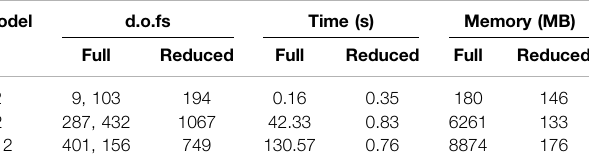
TABLE 3 | The geometrically-reduced models reduce computational cost by orders of magnitude.